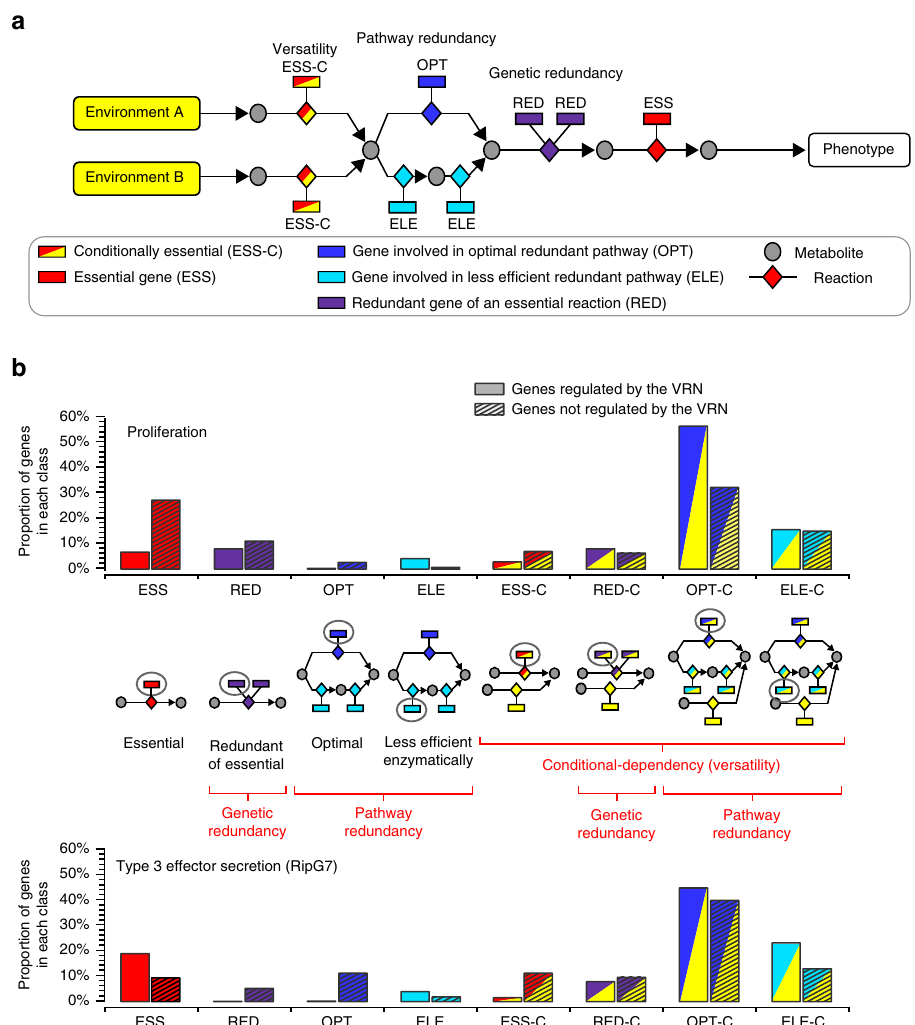
Fig. 5 Sources of phenotypic robustness mobilized by the VRN with respect to internal and external perturbation. a Sources of phenotype robustness in a metabolic network. b Classi fi cation and distribution of genes contributing to robustness of the proliferation phenotype ( n = 78 for VRN-regulated genes and 839 for VRN-independent genes) and the T3SS-dependent secretion of the effector RipG7 ( n = 78 for VRN-regulated genes and 521 for VRN- independent genes) obtained with the BECO analysis. Dependency of the two distributions, VRN-regulated vs VRN-independent, is shown and signi fi cance of the differences was assessed by performing a χ 2 -test. In total 919 metabolic genes were classi fi ed by the BECO